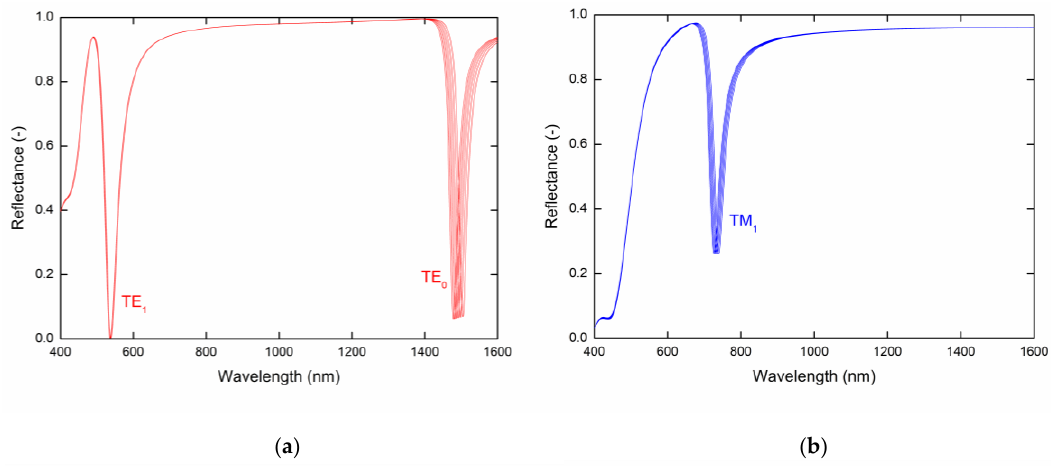
Figure 3. Theoretical spectral reflectances R s ( λ ) ( a ) and R p ( λ ) ( b ) for the PWS and analyte refractive index values in the range 1–1.005 with a step of 0.001.